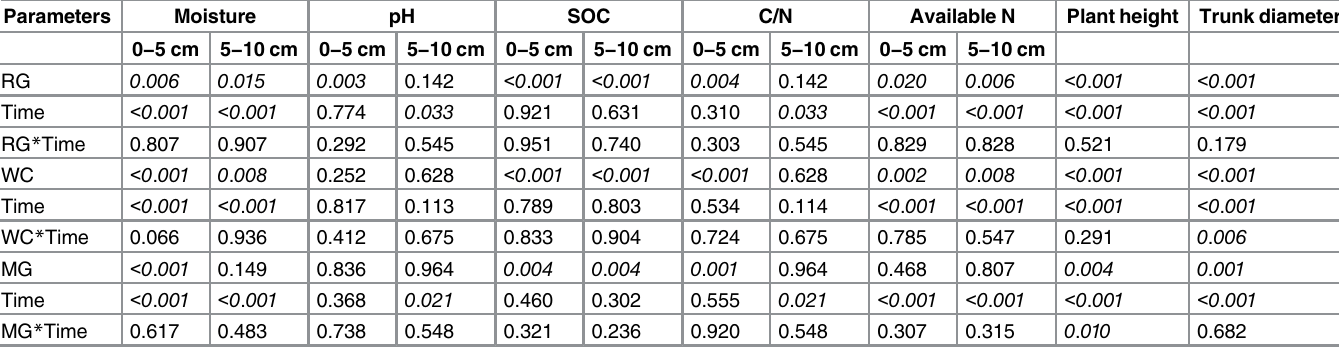
Table 3. Significance ( P < 0.05) of soil properties, plant height, and trunk diameter at the two soil depths (0 – 5 cm and 5 – 10 cm) over time after the three mulching treatments assessed by ANOVA of three replicates.